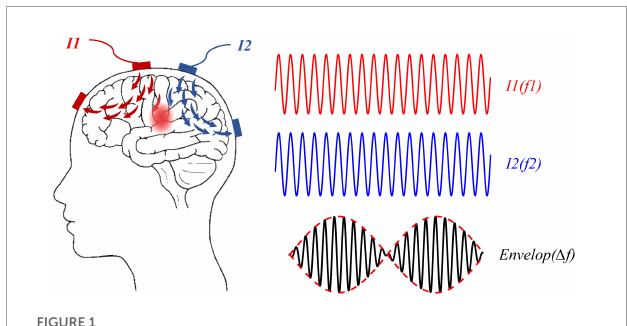
FIGURE1 Temporally interfering (TI) electrical stimulation applied two high-frequency sinusoidal currents, I1 (red line) and I2 (blue line), at a small frequency difference ( (cid:52) f) to a human brain, which could generate a modulation waveform (solid black line), and the envelope of the modulated waveform was a low-frequency waveform (red dotted line) at the difference frequency (cid:52)